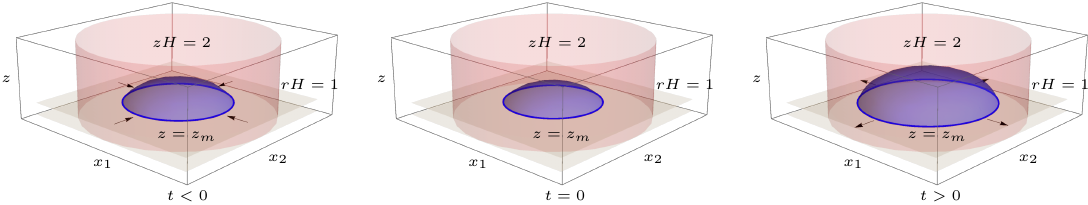
Figure 4 . Snapshots of the (Lorentzian) membrane solution (4.14) as it contracts and expands in time. The cosmological and bulk (acceleration) horizons, at r = 1 /H and z = 2 /H , respectively, are depicted in red. For the sake of the plots, we have only shown the case of a (2 + 1) -dimensional membrane (i.e., with d = 2 ), but the solution is valid for arbitrary d , with the d = 1 case reducing to the string worldsheet studied in